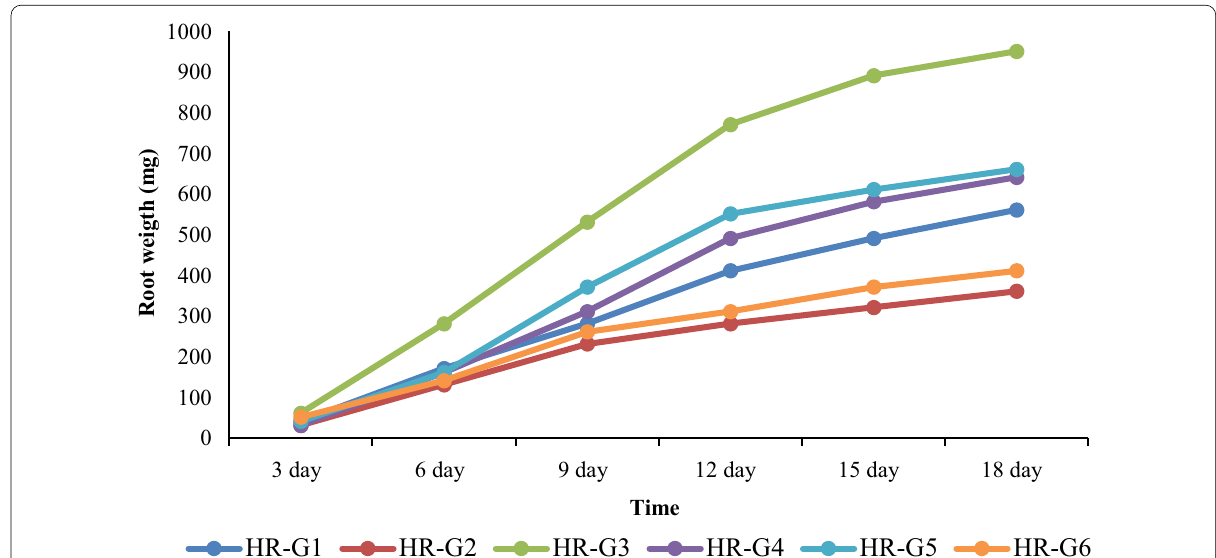
Fig. 4 Comparison diagram of growth of six hairy root lines during several subcultures. The growth rate is based on fresh weight